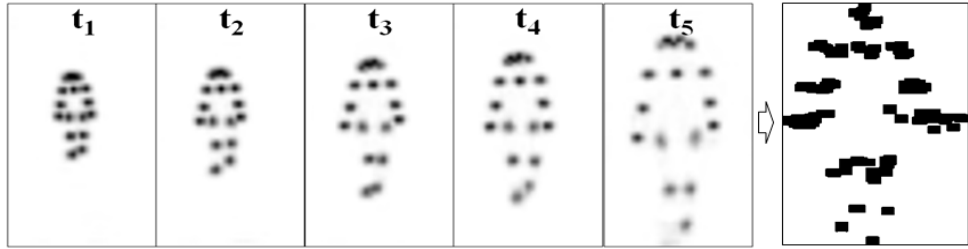
Figure 3. Dynamic joint node plot (DJNP) (right) obtained by merging the heat maps of joint nodes from t 1 to t 5 by using the OpenPose algorithm.